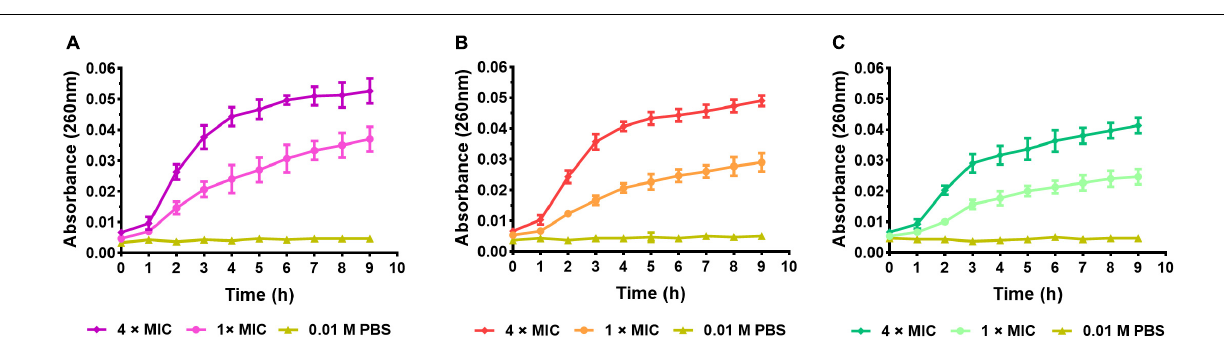
FIGURE 10 | Nucleic acid leakage assay. (A) E. coli (CMCC44103) treated with S1, (B) E. coli (SYPB-3820) treated with S2, (C) S. aureus (CMCC26003) treated with